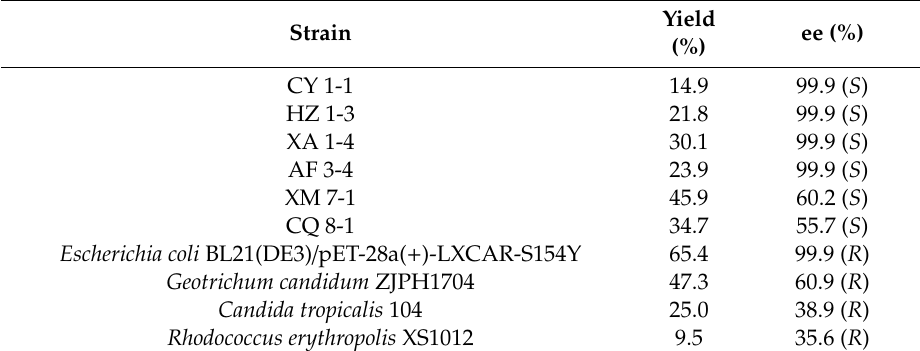
Table 1. The results of some screened